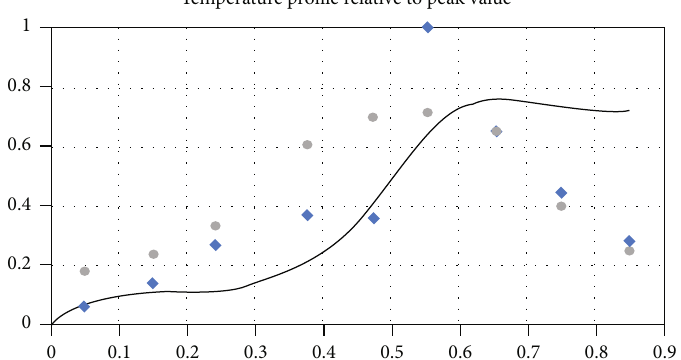
Figure 12: Comparison of temperature distributions on top nacelle surface along the length of hot engine part (- CFD proposed, ○ grey CFD from [11], and ◊ blue 1D model from